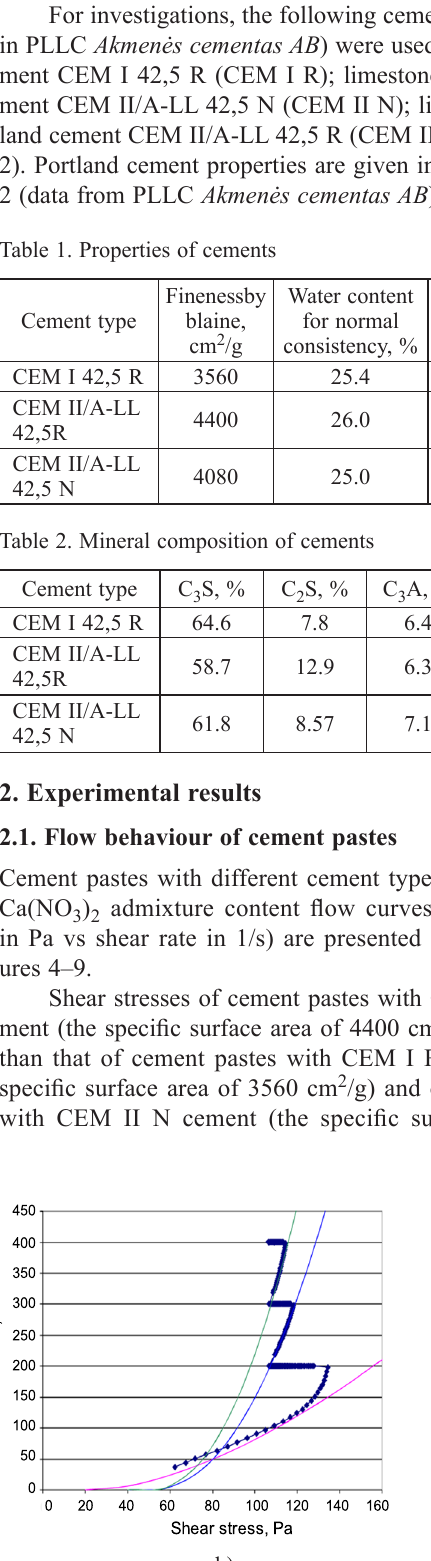
a) Fig. 3. Calculation of yield stress, viscosity and thixotropy of cement pastes from flow curves